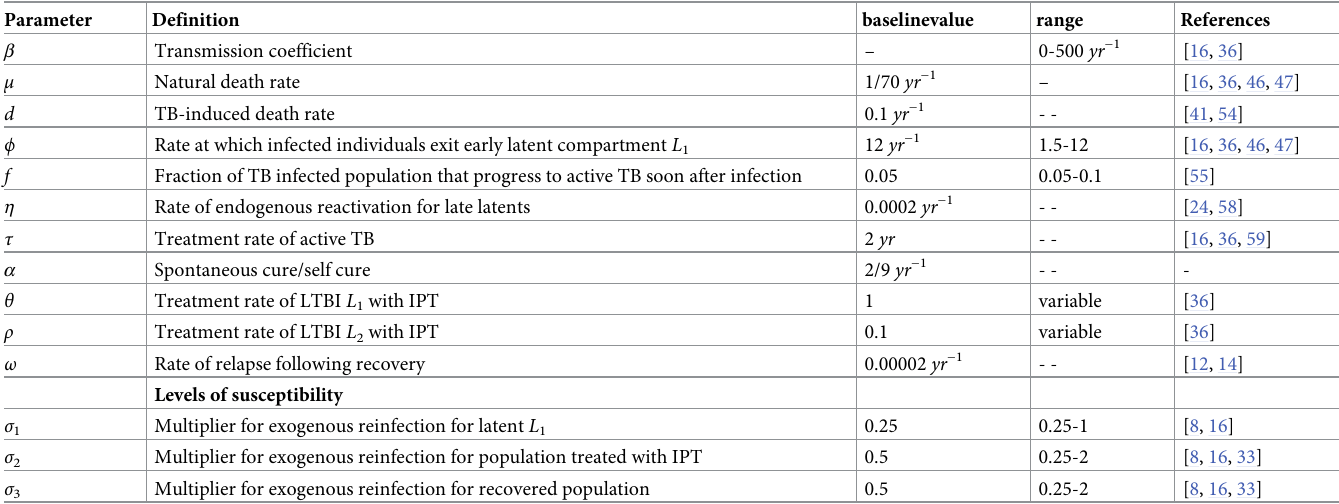
Table 1. Parameters and definitions for model Eq